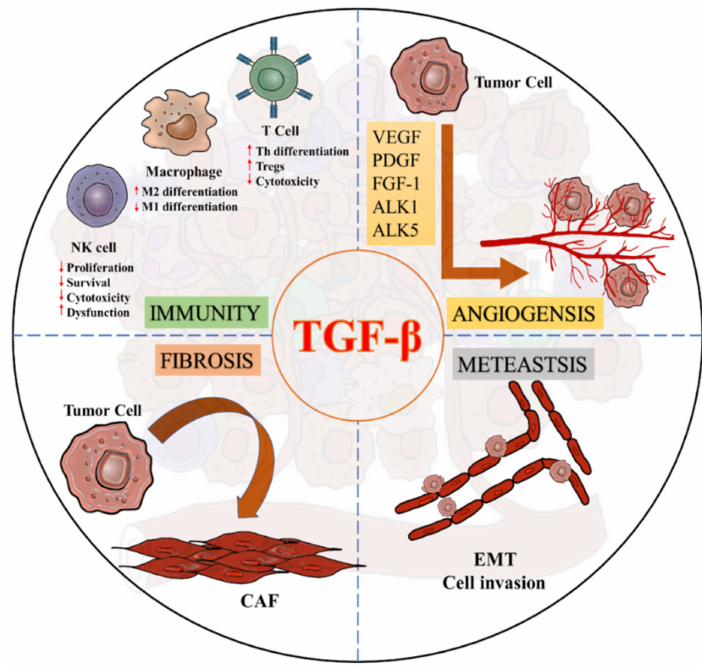
Figure 4. Diverse roles of TGF- β signaling in a pro-tumoral